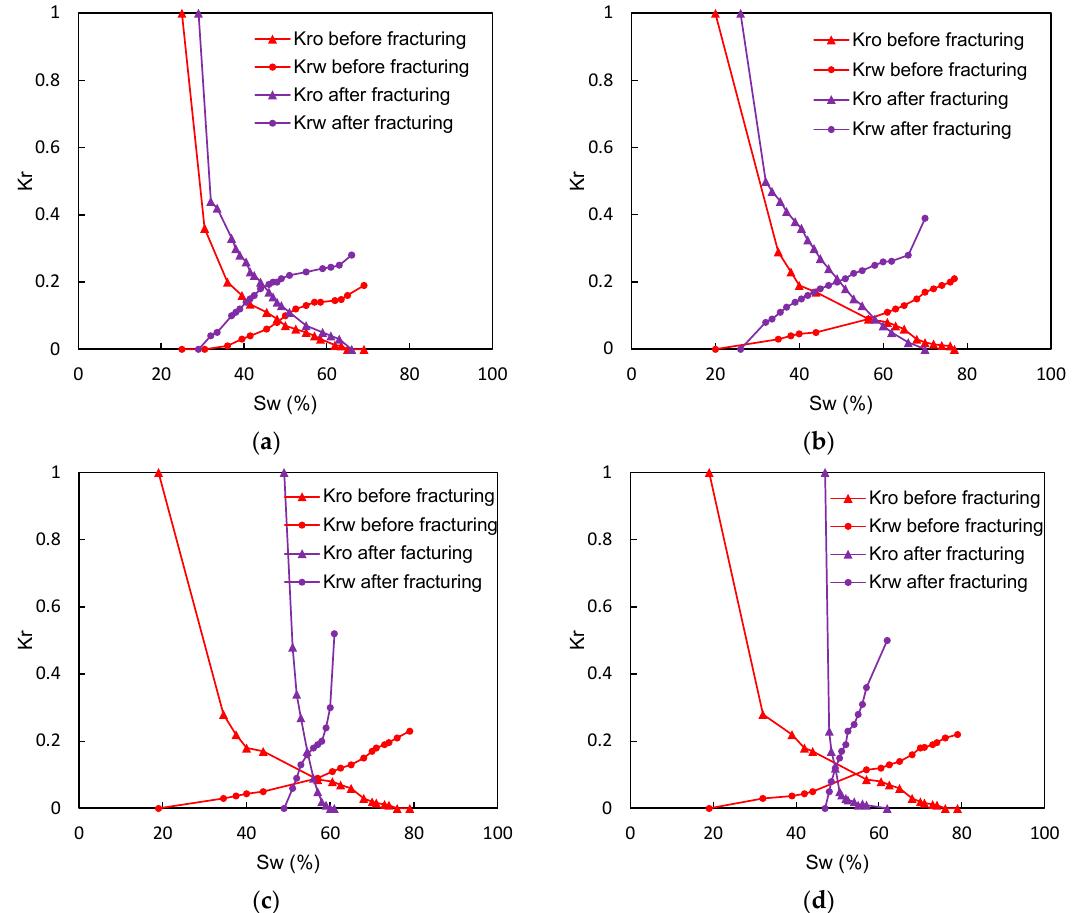
Figure 10. Relative permeabilities of oil and water in the cores before and after fracturing: ( a ) k i = 0.08 mD, k f = 0.19 mD, ( b ) k i = 0.14 mD, k f = 0.36 mD, ( c ) k i = 0.07 mD, k f = 5.48 mD, ( d ) k i = 0.07 mD, k f = 12.14 mD.